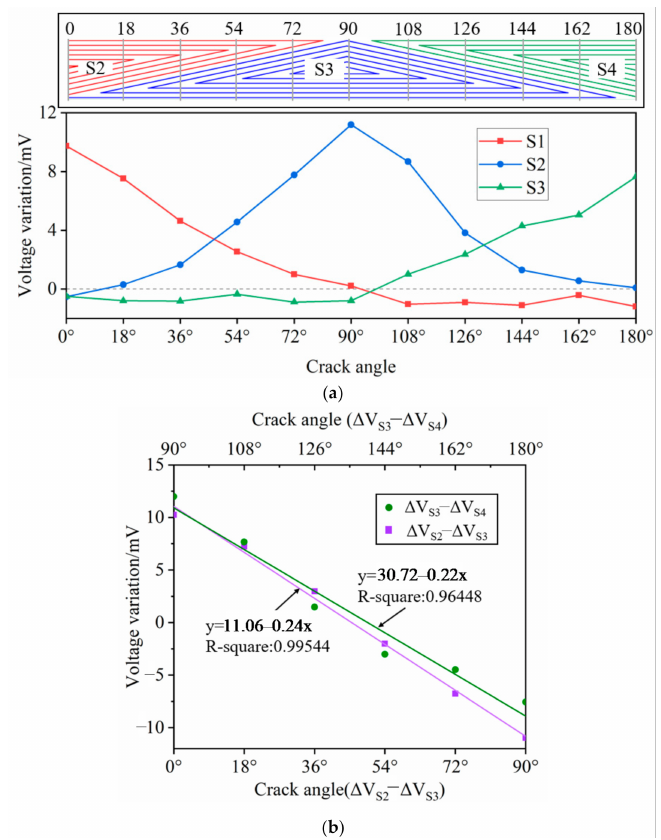
Figure 16. Crack angle detection results. ( a ) Voltage variation of the S2–S4 versus crack angle; ( b ) Voltage difference of S3 (S2) and S4